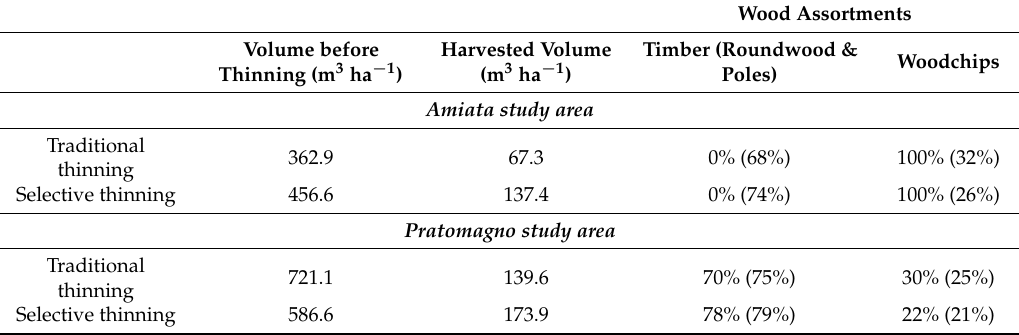
Table 1. Provisioning services before and after thinning in the two study areas. The potential percentage of wood assortment is reported in